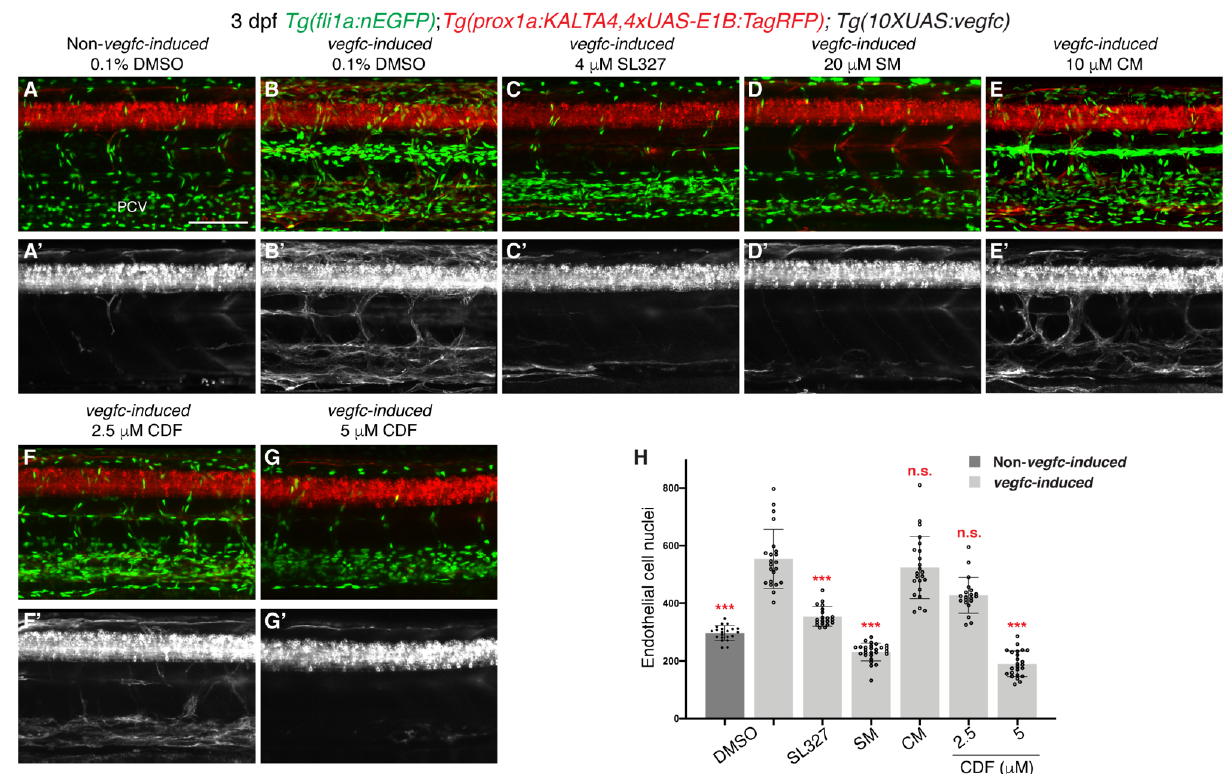
Figure 4. 3,4-Difluorobenzocurcumin inhibits pathological phenotypes associated with vegfc overexpression. ( A – G’ ) Lateral confocal images of either a 3 dpf Tg(prox1a:KALTA4,4xUAS-E1B:TagRFP);Tg(fli1a:nEGFP) larva (Non -vegfc-induced ) treated with 0.1% DMSO ( A , A’ ), or 3 dpf Tg(prox1a:KALTA4,4xUAS-E1B:TagRFP);Tg(10XUAS:vegfc);Tg(fli1a:nEGFP) larvae ( vegfc-induced ) treated with either 0.1% DMSO ( B , B’ ), 4 µ M SL327 ( C , C’ ), 20 µ M sunitinib malate (SM, D , D’ ), 10 µ M curcumin (CM, E , E’ ), 2,5 µ M 3,4-Difluorobenzocurcumin (CDF, F , F’ ), or 5 µ M CDF ( G , G’ ). Pathological vascular phenotypes in vegfc-induced embryos are rescued by CDF treatment. Images ( A’ – G’ ) represent the Tg(prox1a:KALTA4,4xUAS-E1B:TagRFP) expression of images ( A – G ). To avoid the robust prox1a expression in muscle cells, ( A’ – G’ ) are maximum projection images of only the z stacks that contain the posterior cardinal vein. Images ( B’ ) (21/22 embryos), ( E’ ) (23/23 embryos) and ( F’ ) (14/20 embryos) show embryos with increased prox1a:KALTA4,4xUAS-E1B:TagRFP expression in venous endothelial cells. This pathological phenotype is rescued in images ( C’ ) (20/20 embryos), ( D’ ) (27/27 embryos) and ( G’ ) (21/24 embryos). ( H ) Quantification of fli1a:EGFP -positive ECs across 4.5 somites in either 3 dpf non-vegfc-induced treated with 0.1% DMSO (n = 21 embryos) or 3 dpf vegfc-induced larvae treated with either 0.1% DMSO (n = 22 embryos), 4 μ M SL327 (n = 20 embryos), 20 μ M SM (n = 27 embryos), 10 μ M CM (n = 23 embryos), or CDF at 2.5 μ M (n = 20 embryos) or 5 μ M (n = 24 embryos). PCV: posterior cardinal vein. Statistical test: Kruskal-Wallis test was conducted for graph H. p ≤ 0.001 (***) and n.s. indicates not significant. Scale bar: 100 μ m.